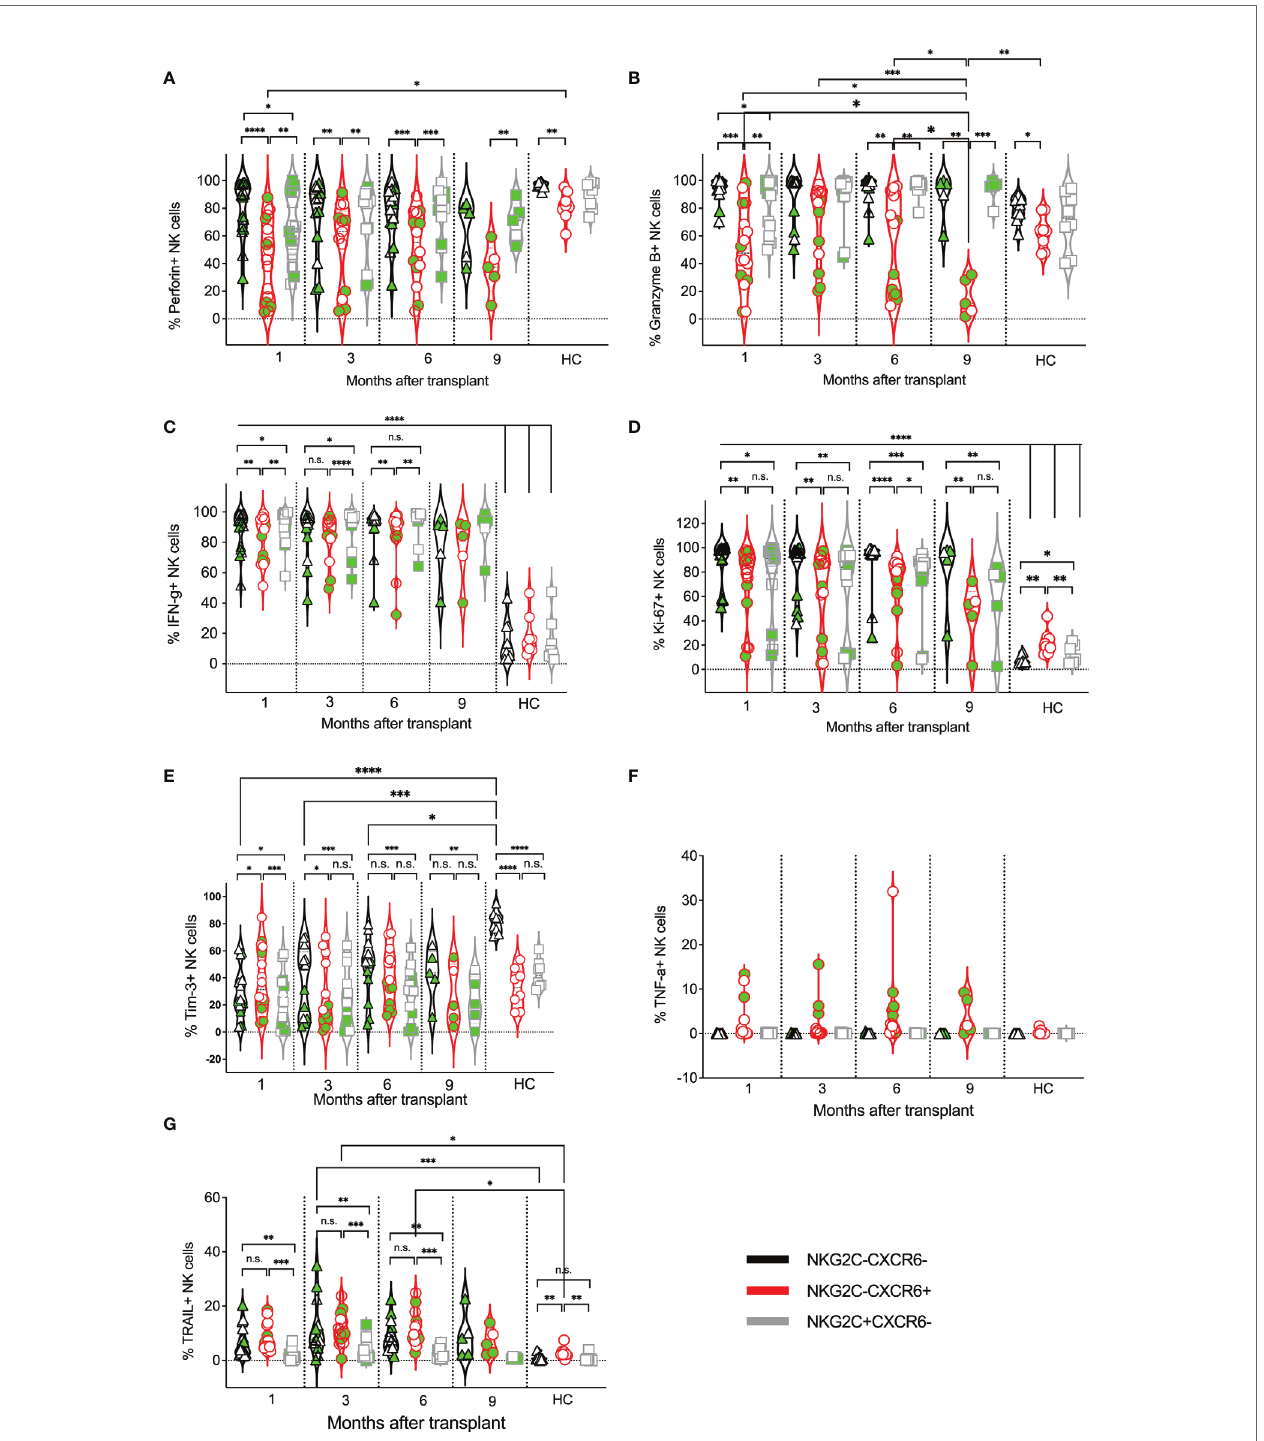
FIGURE 5 | Expression kinetics offunctional markers on CXCR6 – NKG2C – , CXCR6 + , and NKG2C + NK cells post-transplant. The frequencies of indicated functional markers (A – G) were determined for each patient ’ s CXCR6 – NKG2C – , CXCR6 + , and NKG2C + NK cells at indicated time points. Data points in black represent CXCR6 – NKG2C – NK cells; data points in red represent CXCR6 + NK cells, and data points in gray represent NKG2C + NK cells. Circulating healthy adult donor NK cells were also analyzed as a control. Each data point represents a single transplant recipient or healthy adult control donor (HC). Data points with a neon-green fi ll color represent patients positive for CMV up to and at the analysis time as determined by quantitate PCR. *p < 0.05; **p < 0.005; ***p < 0.0005; ****p < 0.0005; Not signi fi cant